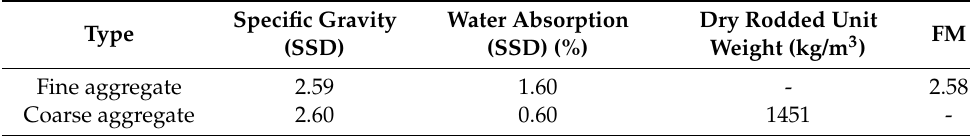
Table 2. Physical properties of the aggregates used.